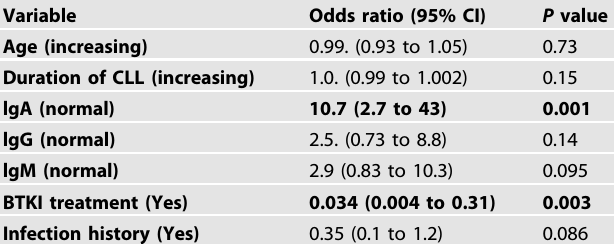
Fig. 4 Determinants of Covid-19 vaccine response in patients with CLL. A Paired analysis of antibody responses to SARS-CoV-2 Spike in healthy donors (HD) and patients with CLL after fi rst and second vaccine (Analysis by TBS ELISA, HD median post 1 st and 2 nd vaccine 1.0 & 5.8 vs CLL median 0.5 & 3.0, respectively) with cut off for positivity shown by dotted line ratio = 1). B Dot plot showing antibody responses to second vaccine in patients with CLL taking a Bruton Tyrosine Kinase inhibitor (BTKi) and those not on BTKi (median BTKi 0.6 vs No BTKi 3.2 p = 0.0002) as measured by TBS assay. C Correlation between antibody response to SARS-CoV-2 following second vaccine and serum immunoglobulin. Antibody levels were measured by TBS ELISA and shown against total serum IgA ( p = 0.0004; r = 0.43, IgA de fi ciency (0.8 g/ L) is highlighted in blue); total serum IgG ( p = 0.02; r = 0.29, IgG de fi ciency (6 g/L) highlighted in blue) and total serum IgM ( p = 0.01, r = 0.334, IgM de fi ciency (<0.5 g/L) highlighted in blue). D Infographic of patients with CLL according to the presence or absence of antibody response following double vaccination according to disease characteristics ( n = 55). Table 2. Univariate analysis of determinants of positive antibody response after second